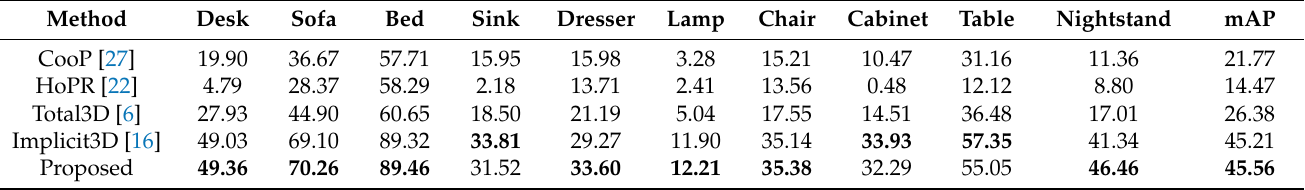
Table 2. Quantitative evaluation results for 3D object detection on the SUN RGB-D dataset. The bolded results represent the highest